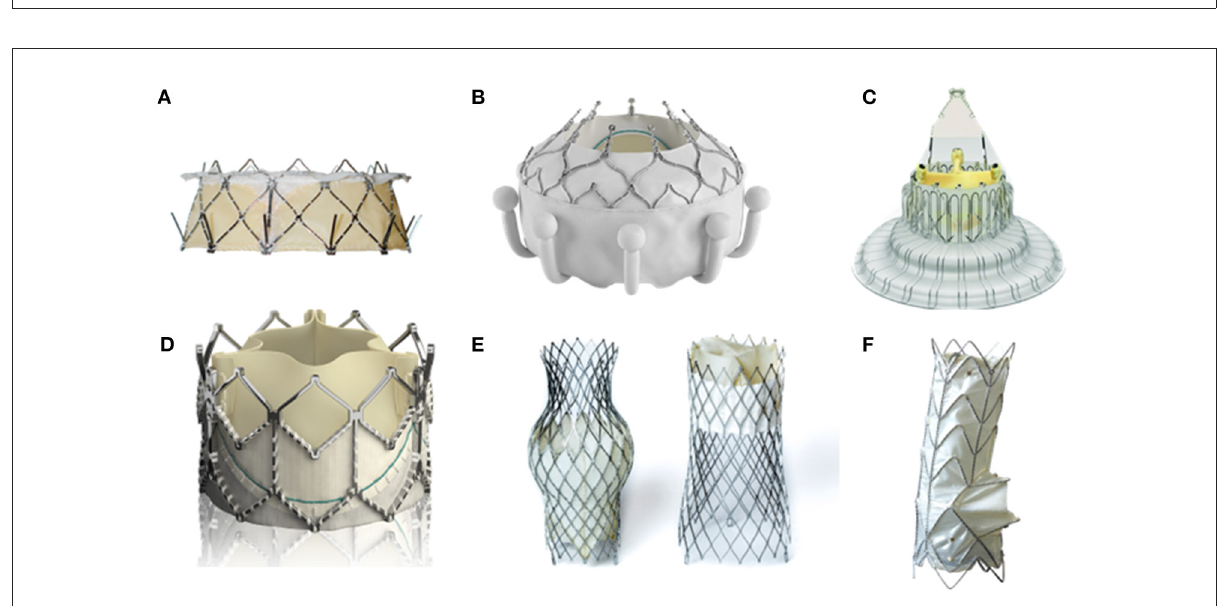
FIGURE3 TTV replacement devices under clinical evaluation. (A) Gate System; (B) Evoque Valve; (C) LuX-Valve; (D) Sapien XT valve; (E) TricValve; (F) Tricento system. Reprinted with permission from the publisher.